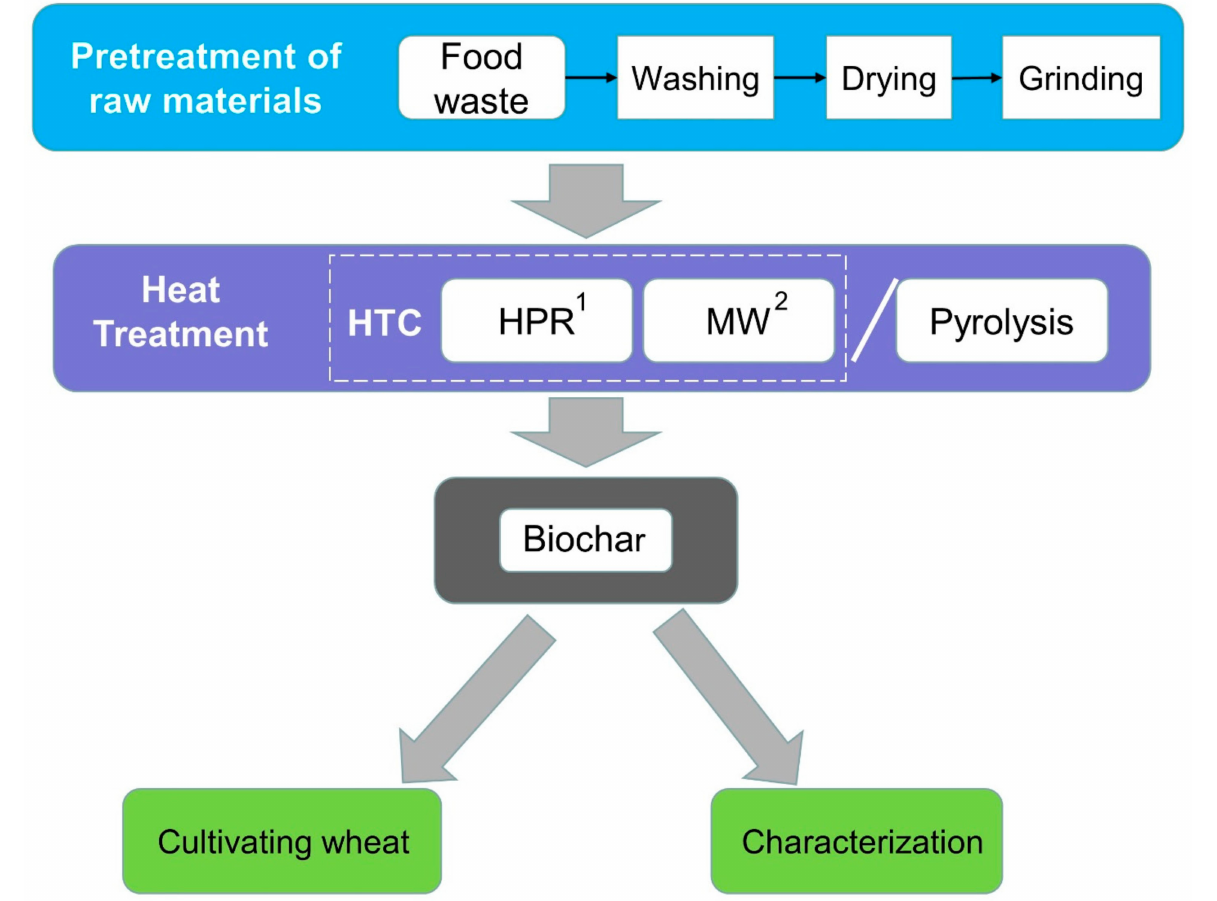
Figure 1. The flowchart of experimental setups. (1. HPR: High-pressure reactor; 2. MW: Microwave.)